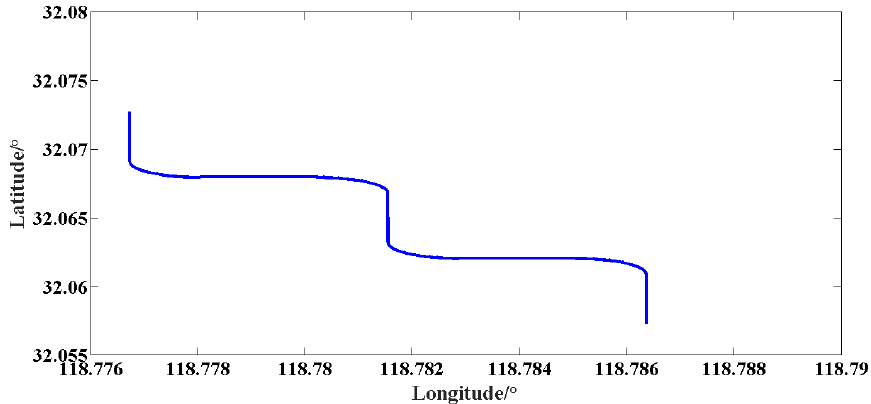
Figure 9. Trapezoidal maneuver path.